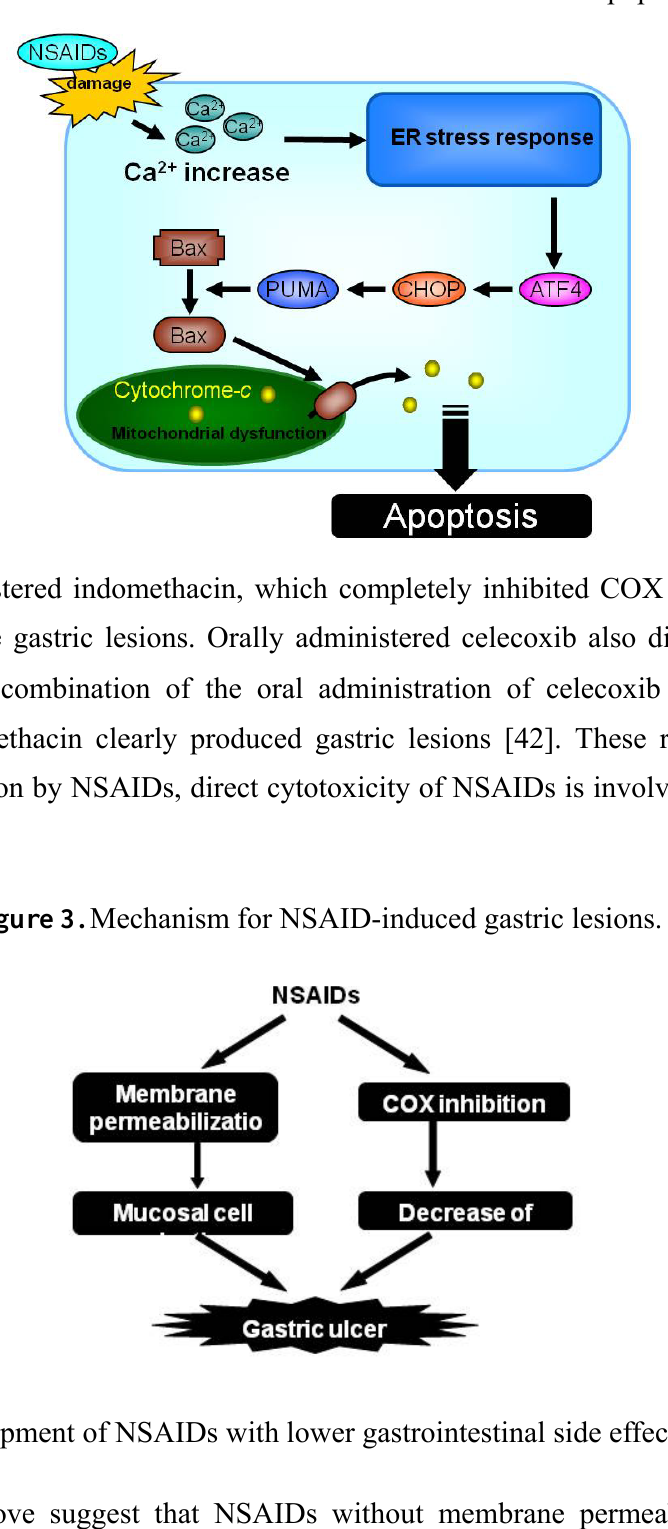
Figure 2. Molecular mechanism for NSAID-induced apoptosis.